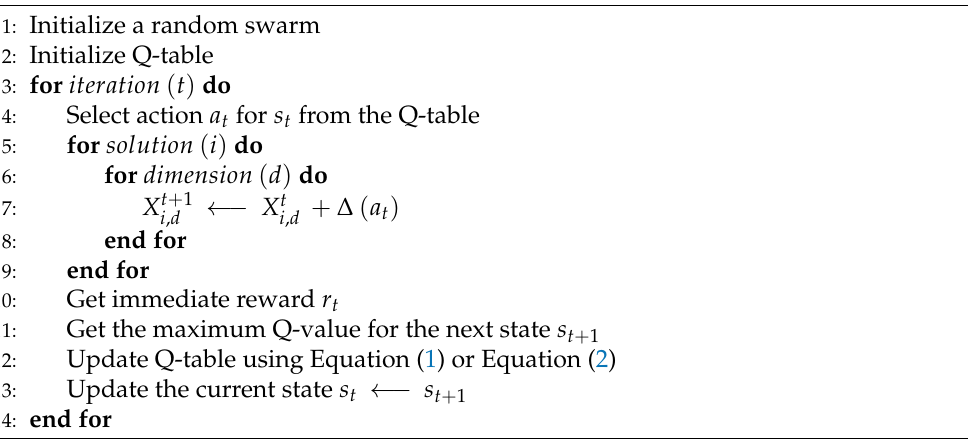
Figure 3. Binarization scheme selector. Algorithm 5 Binarization scheme